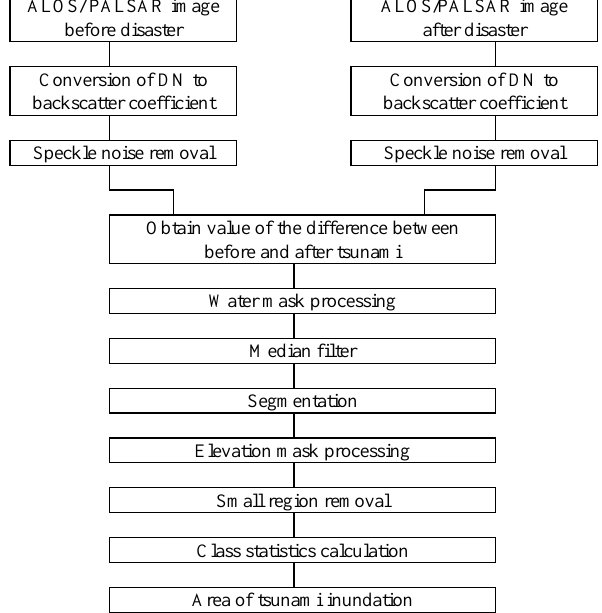
Figure 1. Flowchart of the method of the analysis of tsunami inundation using ALOS/PALSAR satellite images